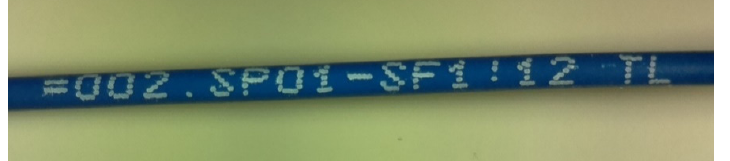
Figure 8. The picture taken by the WLR: clear, readable text; dotted font visible.